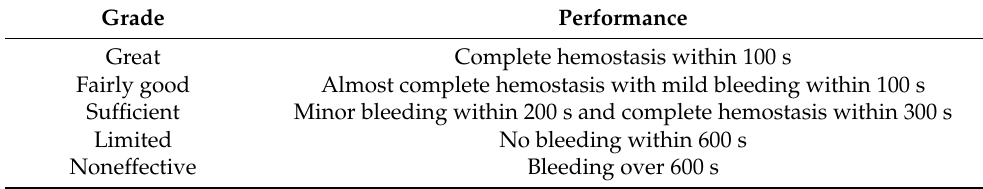
Table 1. Coagulation performance